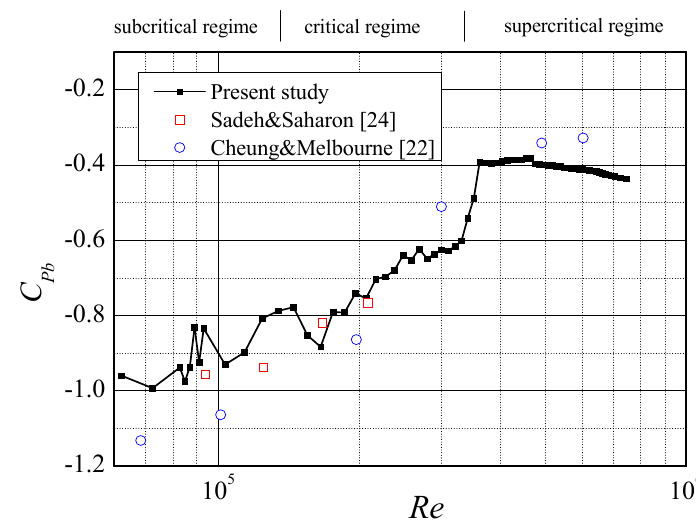
Figure 4. The mean wind pressure coe ffi cient within the base region C pb in the smooth flow.